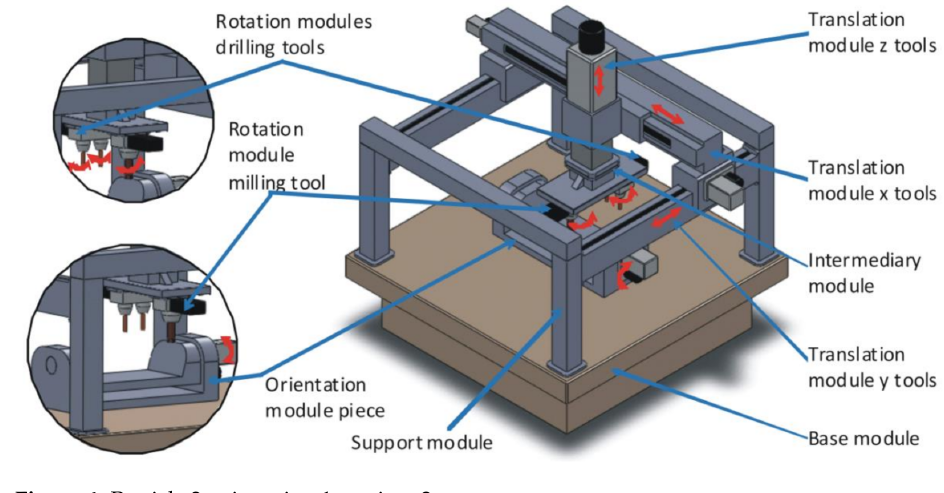
Figure 4. Particle 2 at iteration 1: variant 2.